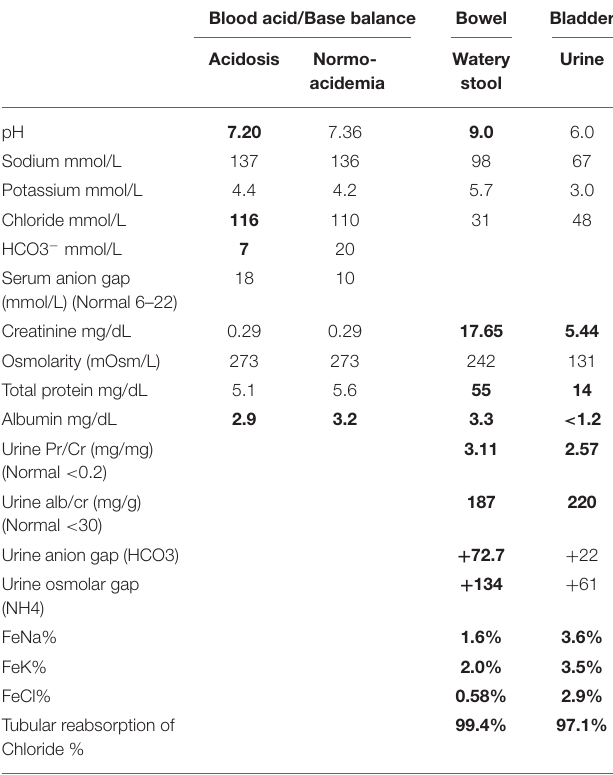
TABLE 1 | Comparison of blood, bowel and bladder solutes during hyperchloremic acidosis induced by uroenteric